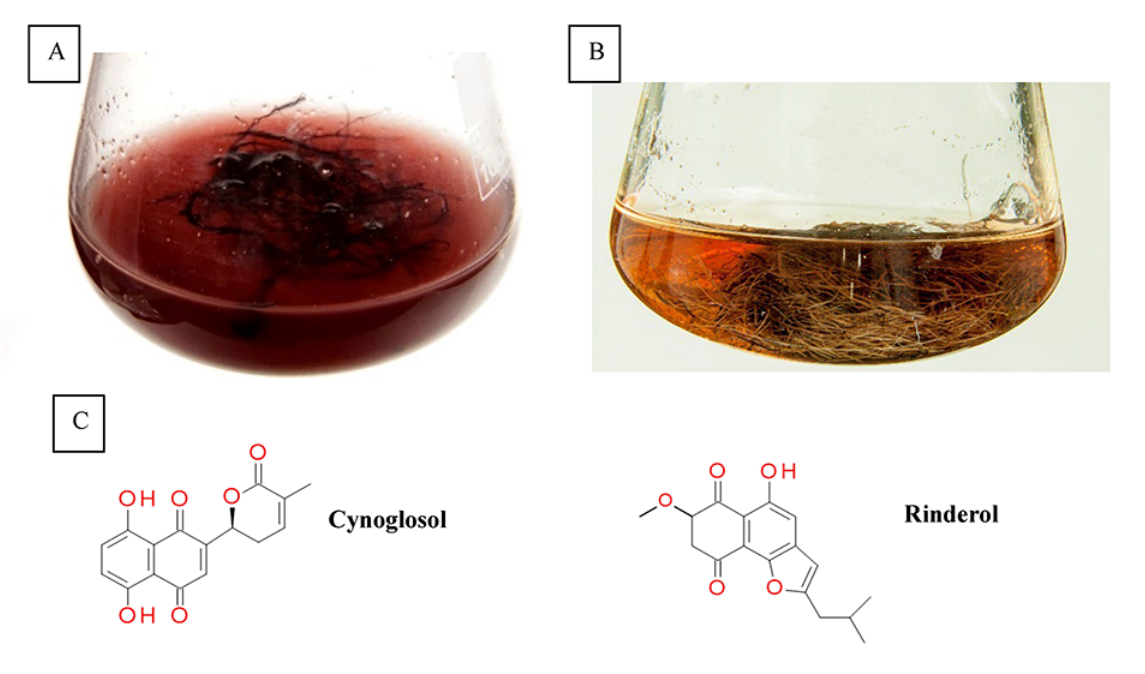
Figure 3 In vitro ( A ) Cynoglossum columnae and ( B ) Rindera graeca root cultures (photo: I. Rudnicki). ( C ) Rinderol and cynoglosol